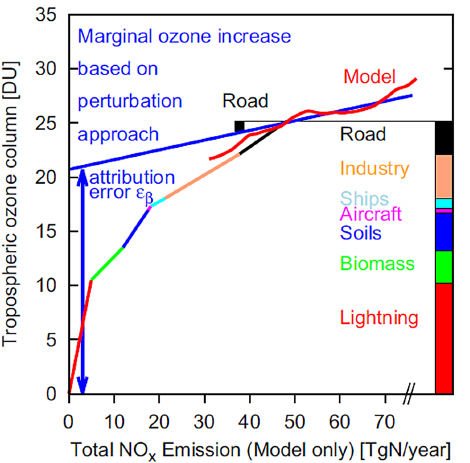
Figure 36. Contribution of individual sectors in terms of NO x emis- sions to the tropospheric ozone column (Grewe et al., 2012b).